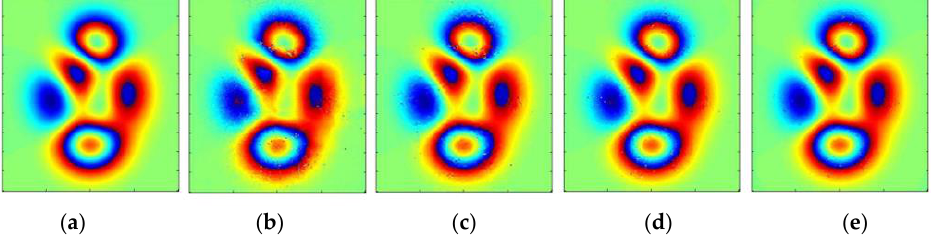
Figure 9. Deformation results of ( a ) true deformation phase; ( b ) the Goldstein filter; ( c ) the wavelet filter; and ( d ) the Lee filter; ( e ) the proposed filter. (Unit: rad).